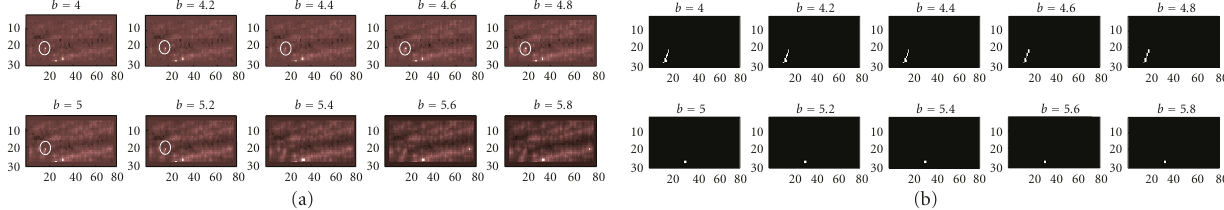
Figure 23: NPA sequence, s n = 3, g = 1 case. (a) The last frame of the algorithm, highest 5 pixels emphasized versus b (target pixel surrounded by a white circle), (b) the target track versus b